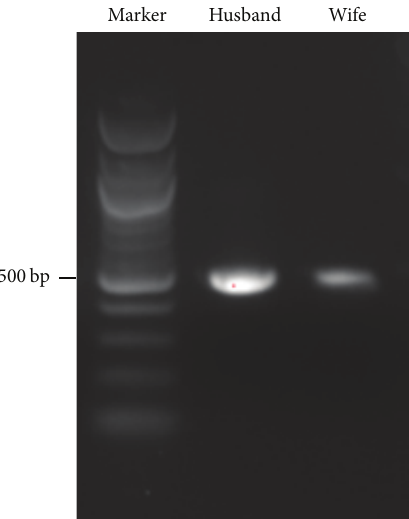
Figure 1: Southern blot of PCR product from HPV16 L1 region. A specific ∼ 500 base pair HPV16 L1 PCR product was amplified from both husband and wife genomic tumor